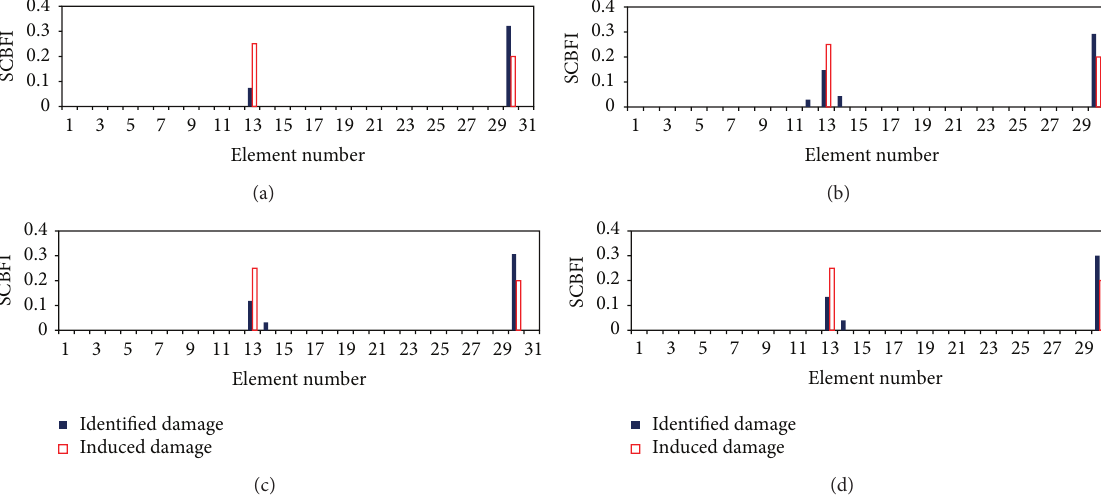
Figure 6: Damage identification for 31-bar truss for case 4 considering (a) 1 mode, (b) 2 modes, (c) 3 modes, and (d) 4